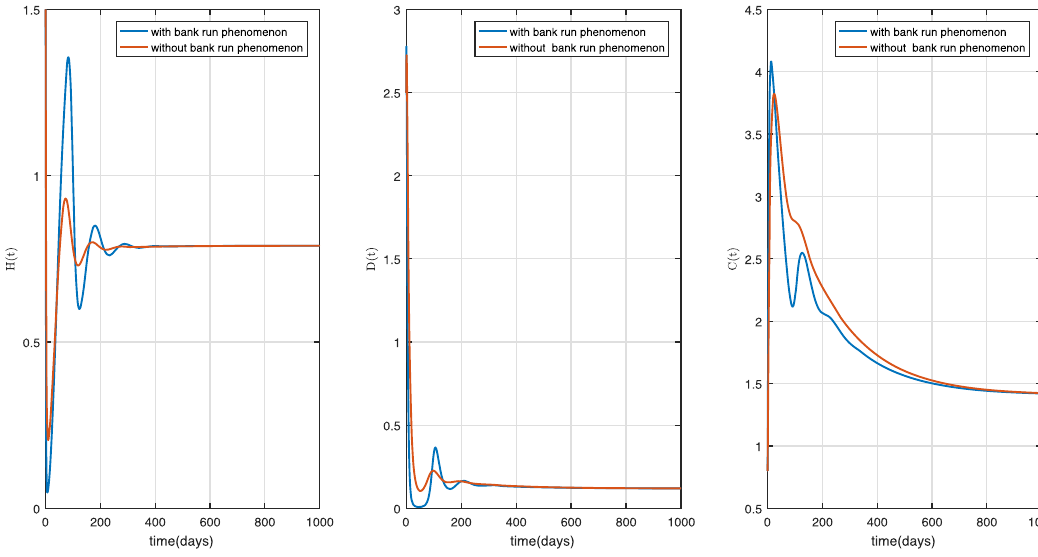
Figure 3: Di ff erence between the evolution of the local banking system with and without the presence of rumor about the fi nancial health of given